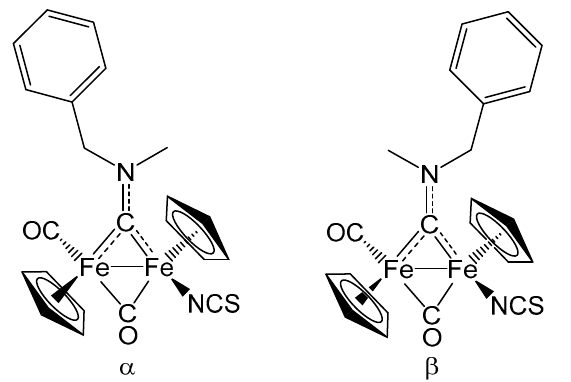
Figure 7. Thiocyanate complex [Fe 2 Cp 2 (k N ‐ NCS)(CO)(µ ‐ CO){µ ‐ CN(Me)(CH 2 Ph)}], 3 . A mixture of [ 1d NCMe ]CF 3 SO 3 , freshly generated from [ 1d]CF 3 SO 3 (90 mg, 0.148 mmol) according to the procedure above, and NBu 4 SCN (220 mg, 0.733 mmol) in CH 2 Cl 2 Figure 4. Structure of [Fe 2 Cp 2 (k N- NCO)(CO)(µ-CO){µ-CN(Me)(Xyl)}], 2a . From [1a]CF 3 SO 3 (268 mg, 0.432 mmol), Me 3 NO·2H 2 O (53 mg, 0.47 mmol), and